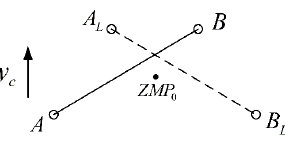
Figure 21. Position of 𝑍𝑀𝑃 0 and the support lines